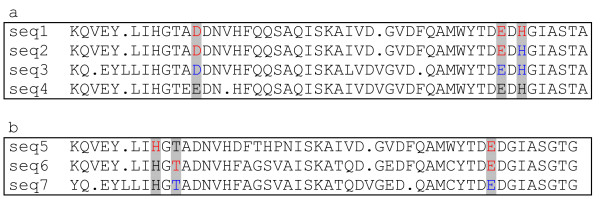
Two example alignments (a and b) showing scenarios in which residues are predicted to be active site residues using our rule based methodology. Residues in red denote an experimental active site, and residues in blue denote predicted active site residues. Grey columns indicated the presence of experimental active site data in the alignment, and these are the columns in the alignment which are methodology focuses on. See Construction and Content for details.